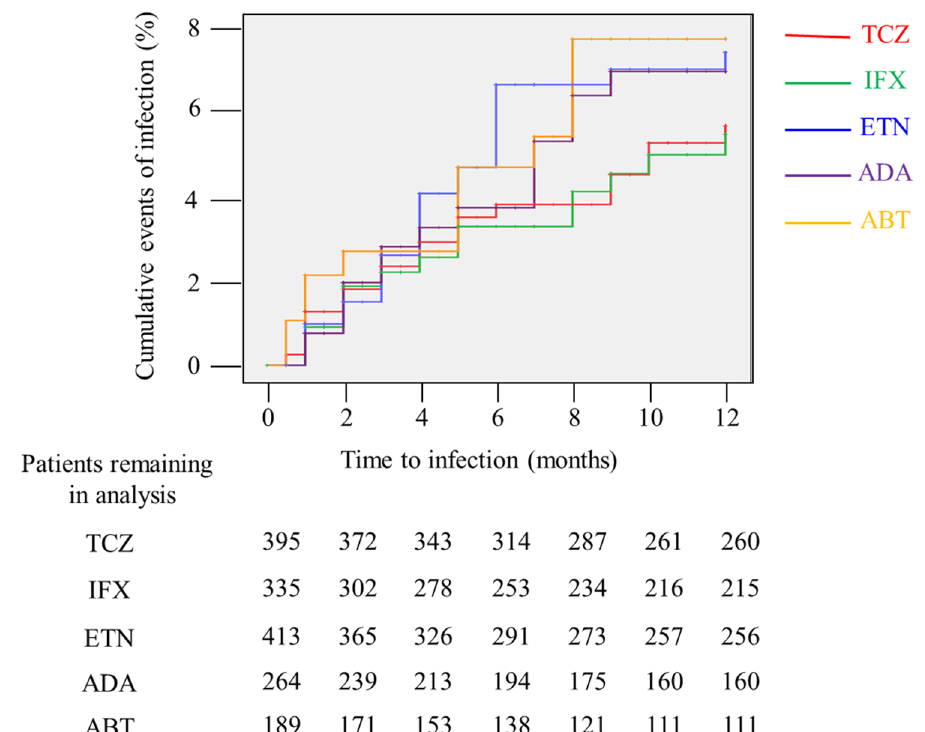
Fig 1. Cumulative incidence of hospitalized infection during the first year of follow-up, according to biological agent. Numbers below this figure represent the numberof patients remainingin the analysis. TCZ, tocilizumab; IFX, infliximab;ETN, etanercept; ADA, adalimumab; ABT, abatacept.